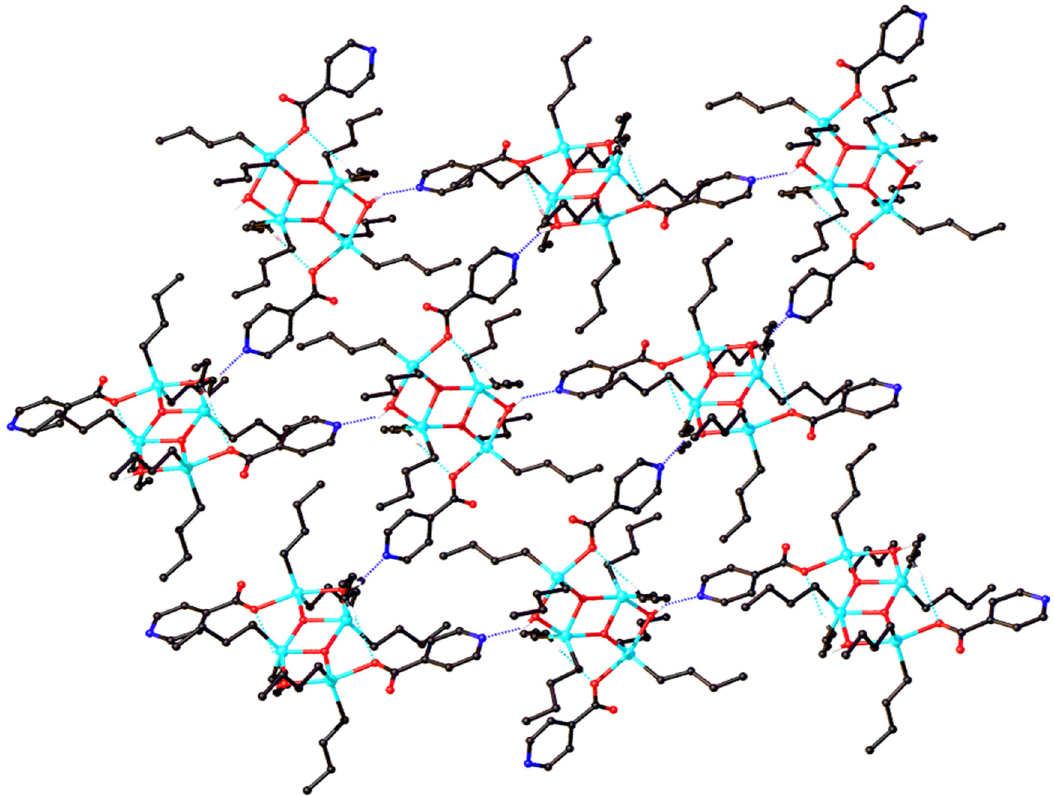
Figure 3: Crystal structure in in fi nite chain of [ C 5 H 4 N -( p - CO 2 )] 2 [ Bu 2 Sn ] 4 ( μ 3 - O ) 2 ( μ 2 - OH ) 2 ( 1 ) with intermolecular hydrogen bonds O – H ··· N ( color code: blue ) and intramolecular hydrogen bonds C – H ⋯ O ( color code: greenish ) . Only C ipso of the n - butyl groups are shown for clarity.